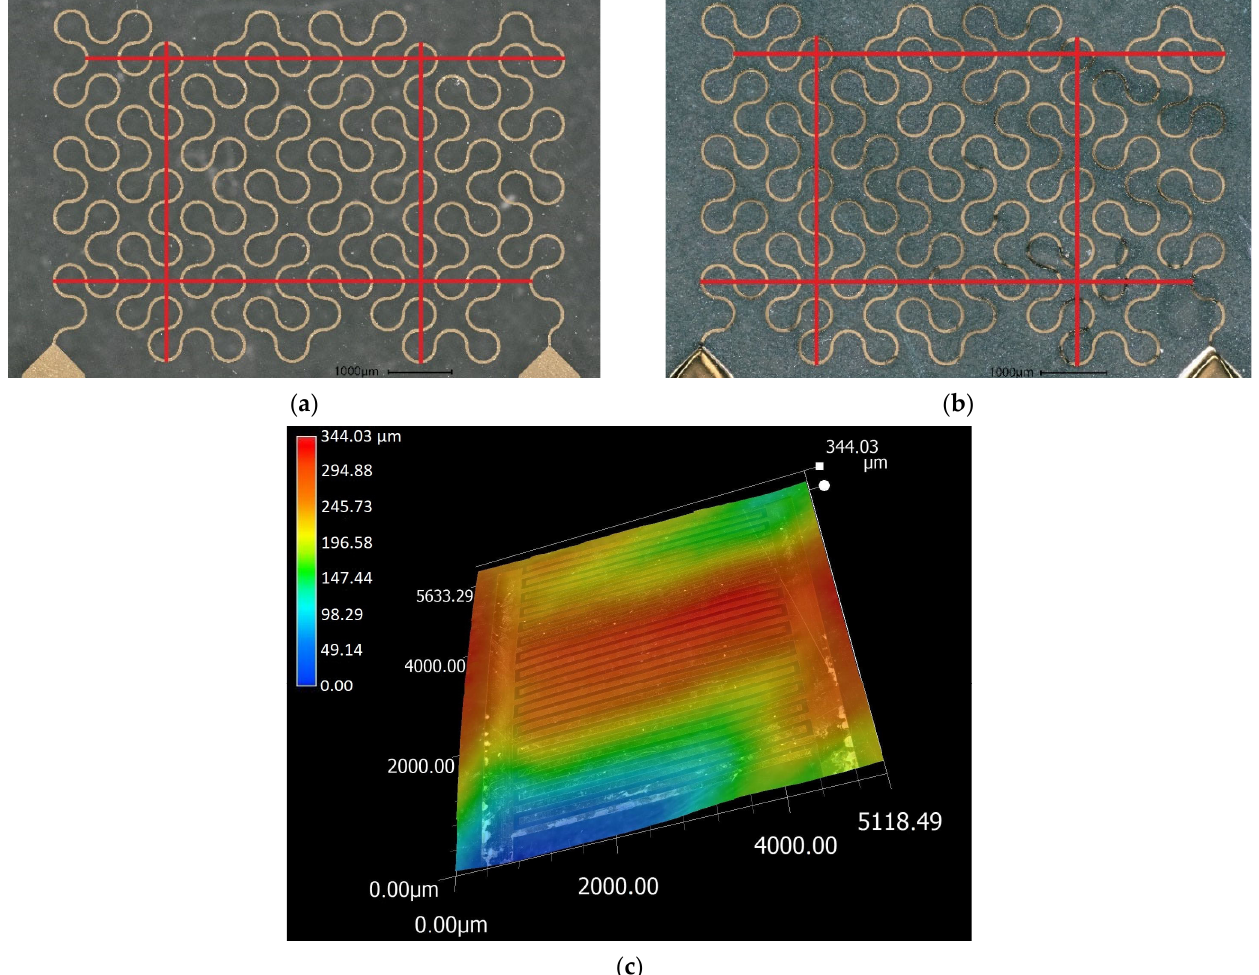
Figure 6. ( a ) Sensor node still attached to the wafer; ( b ) sensor node after detachment and extended burn-in, length measurements between the indicated lines reveal a shrinkage of 1% in all directions; ( c ) waviness of the sensor node foil as obtained by digital microscopy (VHX5000, Keyence) in the area of the capacitive sensor fixed with adhesive tape to a flat waver surface.